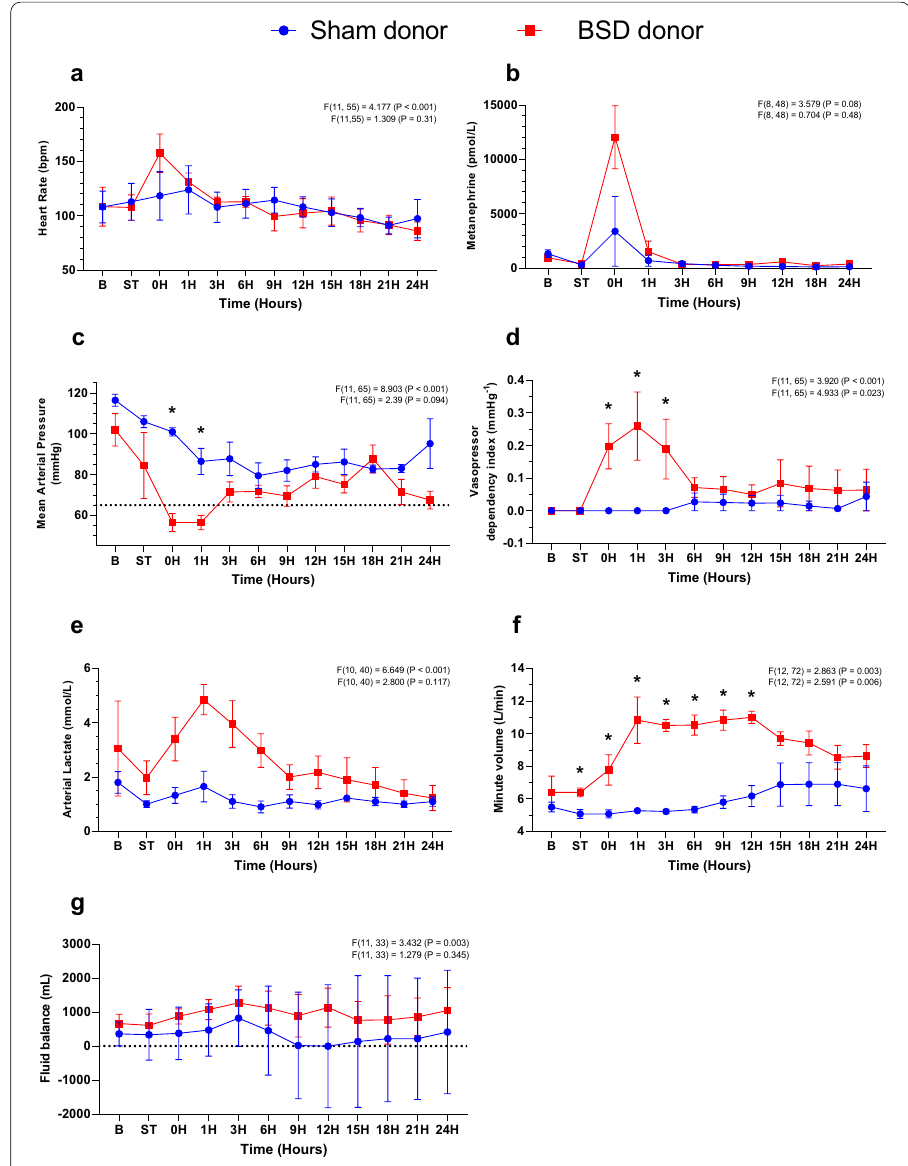
Fig. 3 Donor hemodynamics following confirmation of BSD . Changes in a heart rate (bpm); b plasma metanephrine (pmol/L); c mean arterial pressure (mmHg); d vasopressor dependency index (mmHg − 1 ); e arterial lactate (mmol/L); f minute volume (L/min); and g fluid balance (mL) following confirmation of donor BSD (or sham). Data are mean SEM, n 4/group. Top F and p values on each graph represent effect of time, ± = and bottom F and p values represent differences between BSD vs. sham over time. B Baseline, ST